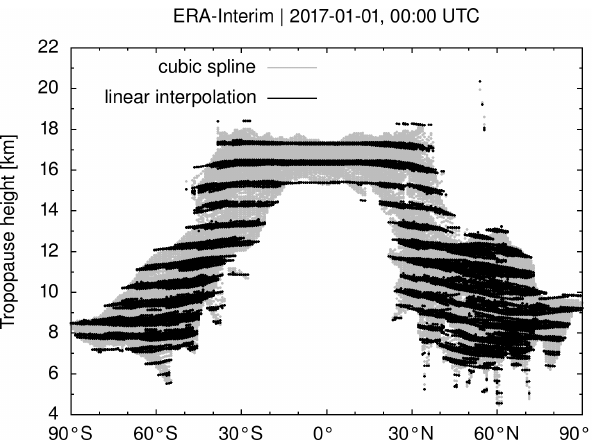
Figure B1. Tropopause geopotential heights from ERA-Interim data for 1 January 2017, 00:00. The tropopause heights were esti- mated by applying linear interpolation (black dots) and cubic spline interpolation (gray dots) to refine the vertical temperature profiles of the reanalysis